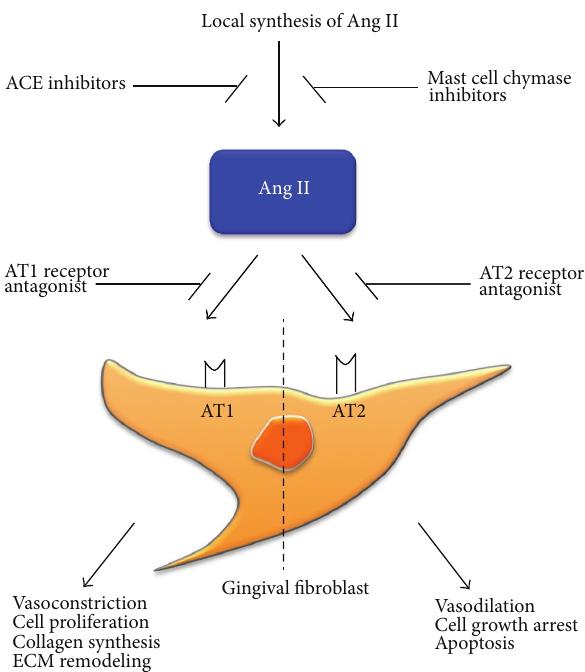
Figure 2: Potential role of angiotensin II and its receptors expressed by fibroblast in gingival fibrosis. Ang II: angiotensin II; AT: angiotensin receptor; ACE: angiotensin-converting enzyme; ECM: extracellular matrix.